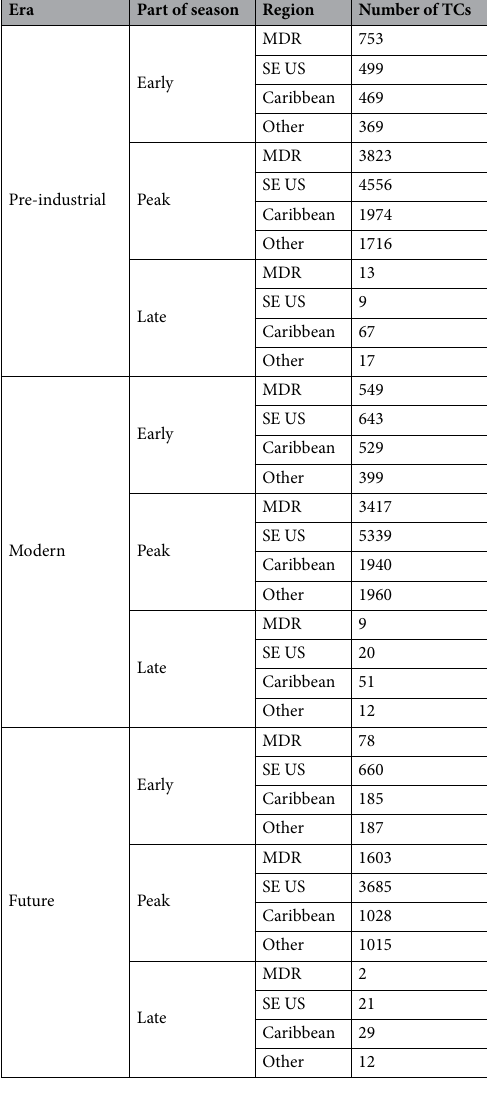
Table 3. Number of TCs in each region for each era and part of the season compared with the total number of TCs in that